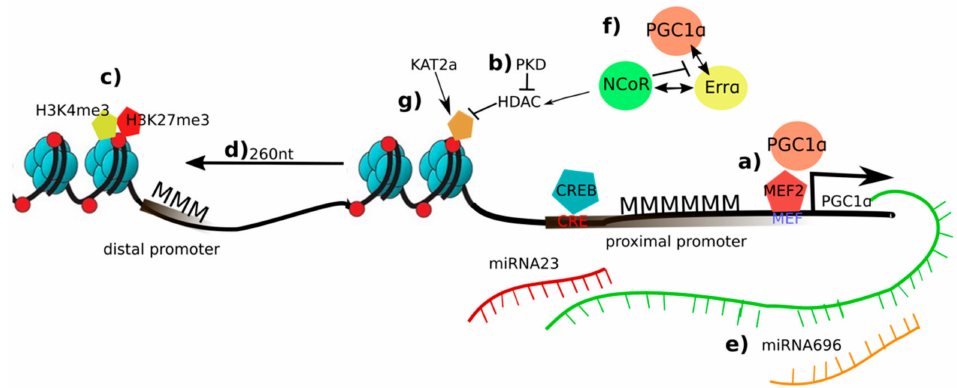
Figure1. Overviewofepigeneticchangesontheperoxisomeproliferator-activatedreceptor γ